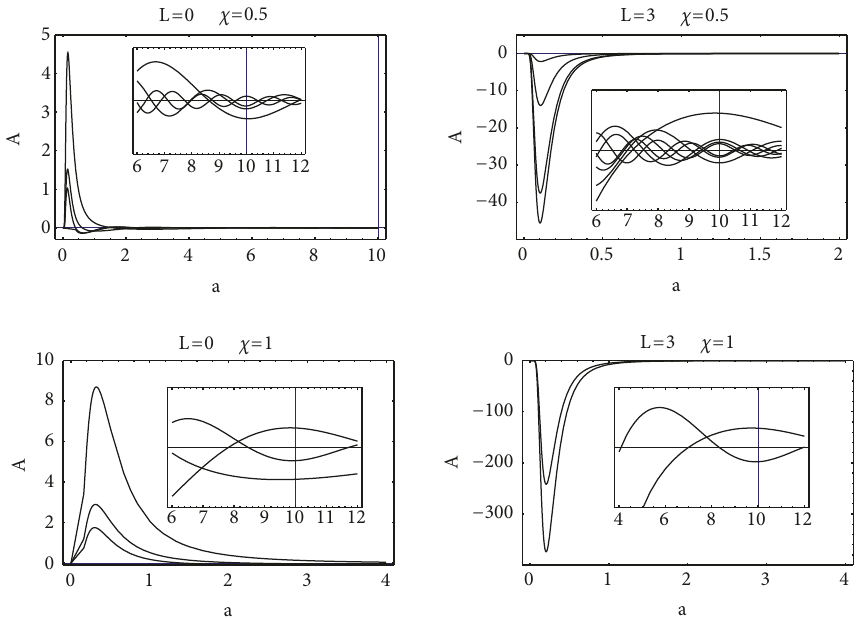
Figure 5: Examples of the application of the boundary conditions at 𝑎 ∞ = 10 , for the dipole equation analytic solution. The positive part of the spectrum 0 < 𝐸 < 1 , for 𝐿 = 0, 3 , and 𝜒 = 0.5, 1 . In the main window we present the whole wave function, and in the smaller window we zoom in to the zero derivative point at 𝑎 = 𝑎 ∞ . The number of eigenstates (oscillations) increases with 𝐿 , and decreases with 𝜒 , because for smaller dipole strength the solution is closer to the Bessel solutions. The eigenvalues of energy are 𝐸(𝐿, 𝜒) = 𝐸(0,0.5) = 0.06,0.32,0.78,0.92 ; 𝐸(3,0.5) = 0.02,0.16,0.23,0.41, 0.52,0.64,0.77 ; 𝐸(0,1) = 0.085,0.44,0.985 , and 𝐸(3,1) = 0.32, 0.88 . Higher energy states have more